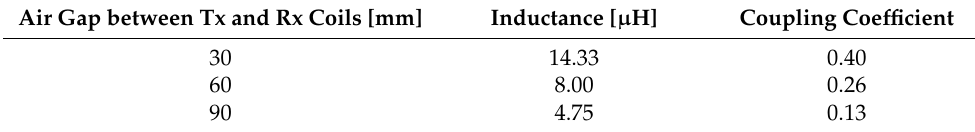
Table 10. Measured inductance and resistance of WPT coils.